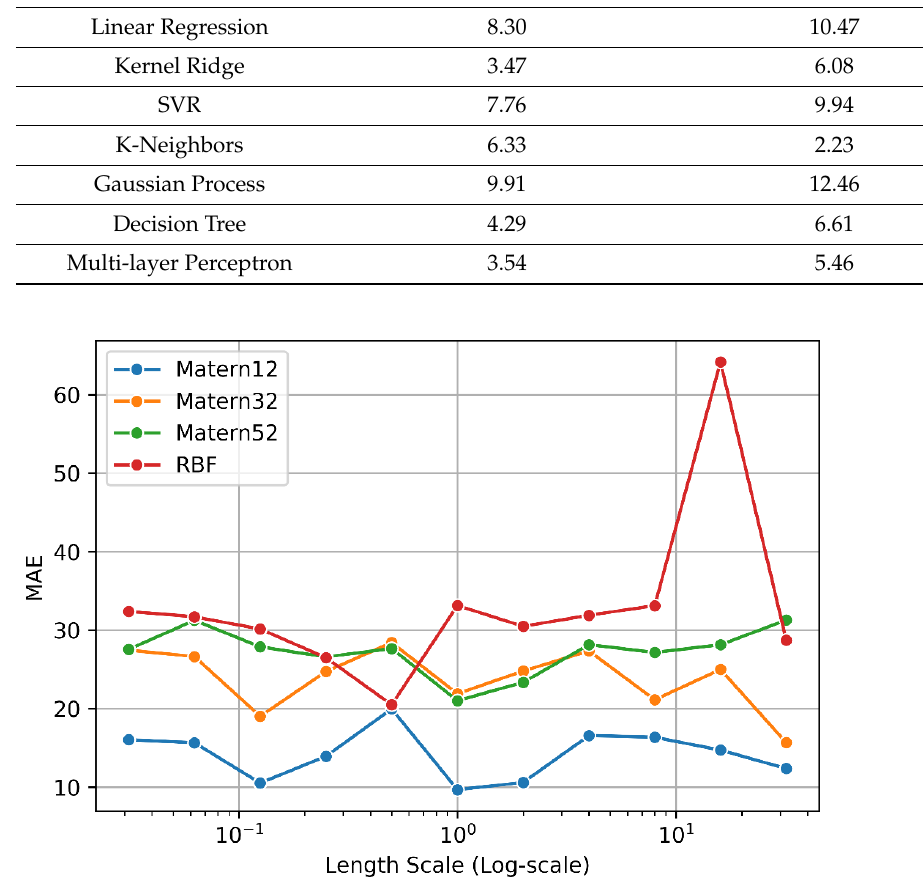
Table 2. Mean Absolute Error (MAE) and Root Mean Squared Error (RMSE).